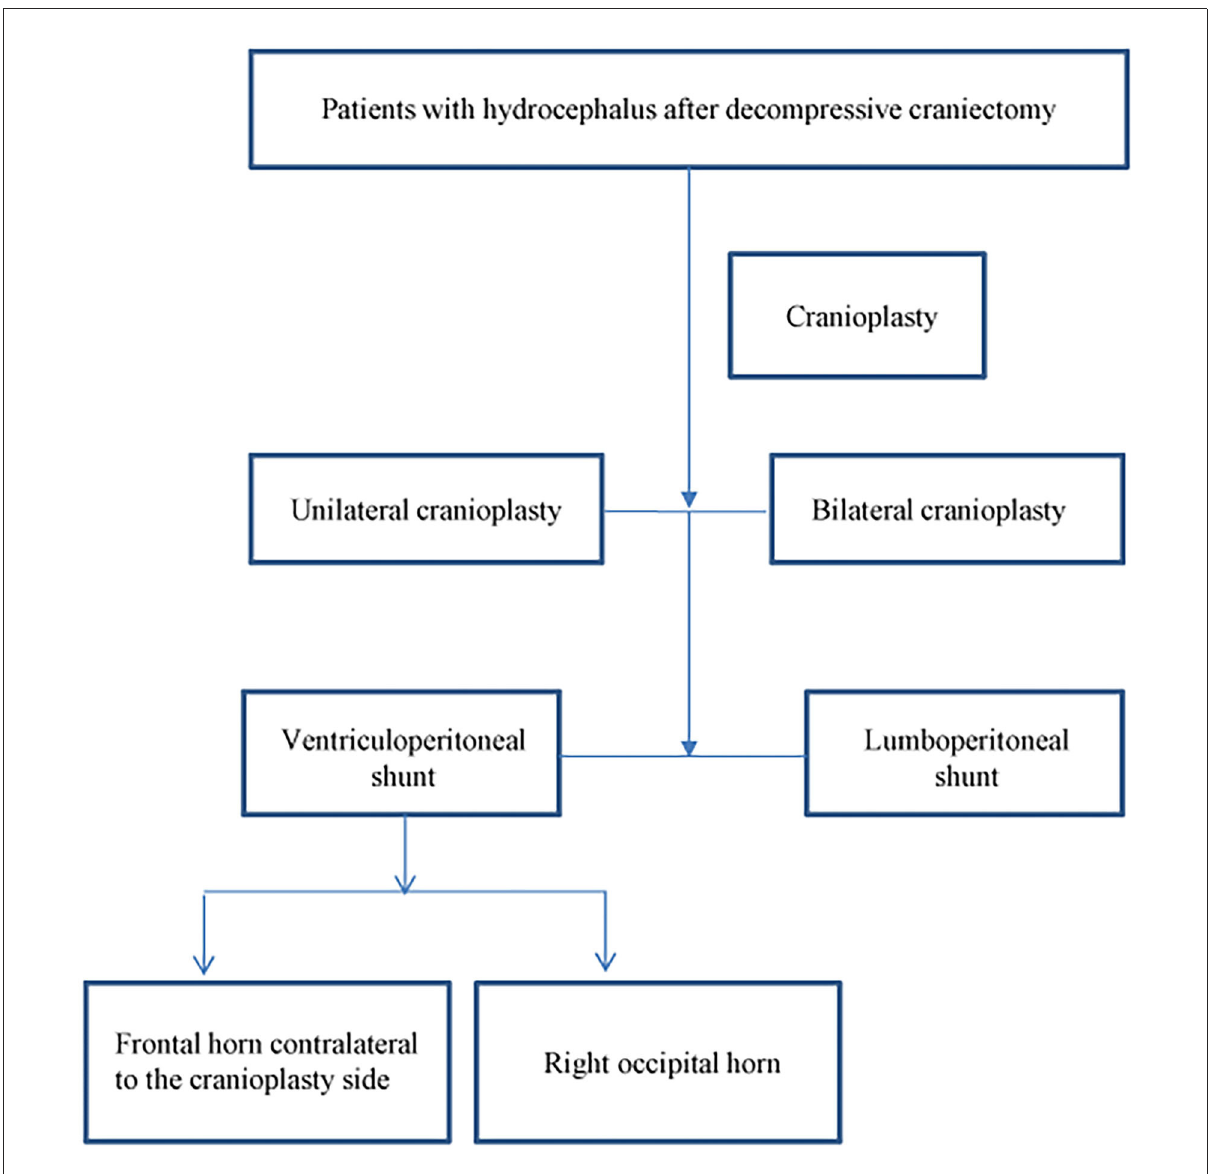
FIGURE9 Clinical treatment flow chart for patients with hydrocephalus after decompressive